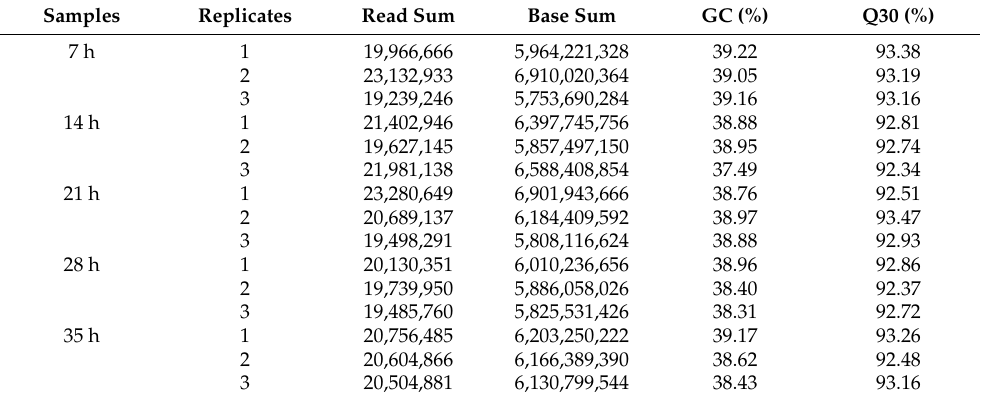
Table 1. Summary statistics of sequencing data for the transcriptomes of different development time points in T. urticae